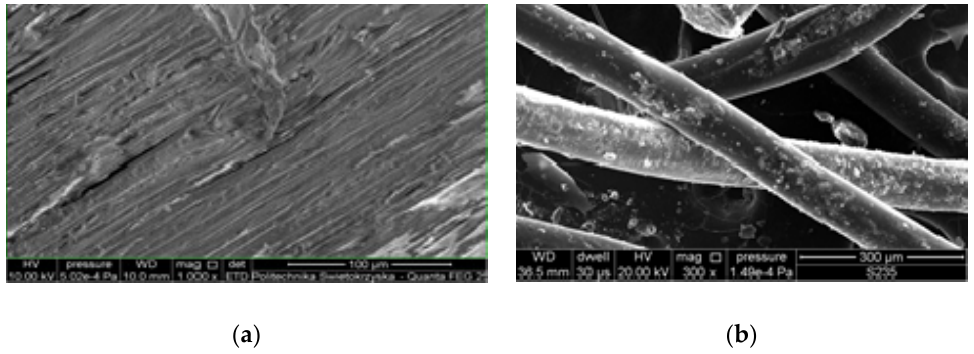
Figure 14. Scanning electron microscope (SEM) images of wood: ( a ) dry wood, vertical section, magnification 10 3 ×; and ( b ) natural plant fibers, magnification 3 × 10 2 ×. Image acquired on the scanning electron microscope Quanta 250 FEG (FEI Company).